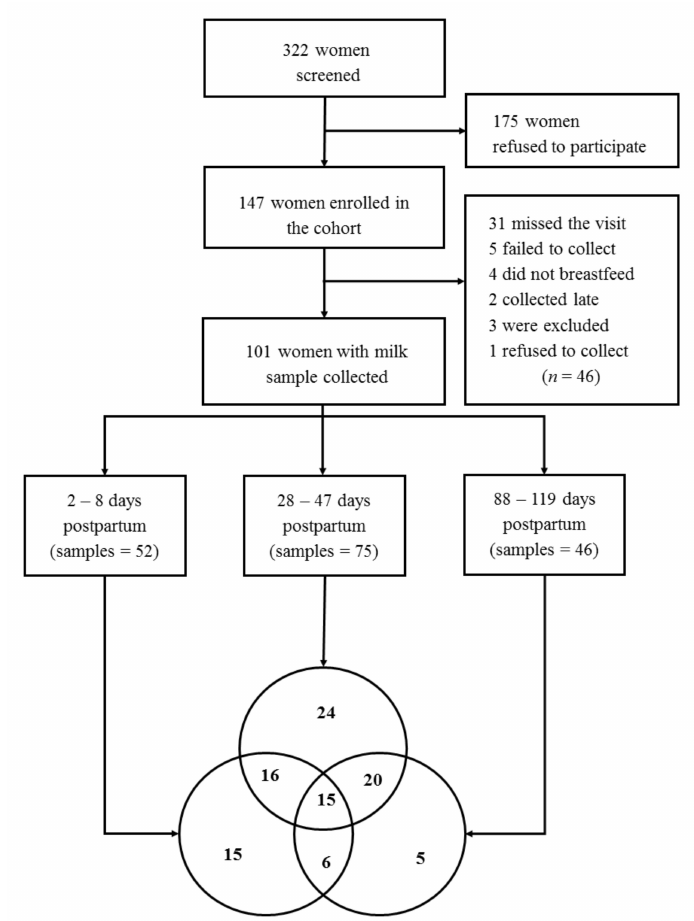
Figure 1. Flow of women and human milk samples of the Brazilian cohort, totaling 101 women with 174 milk samples. The flow intersection represents the women with samples in two or more follow-up